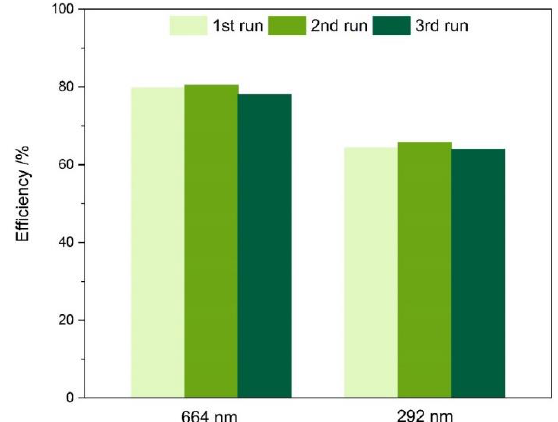
Figure 9. Effect of recycling test of immobilised g -C 3 N 4 on alumina substrate for photocatalytic degradation of MB.